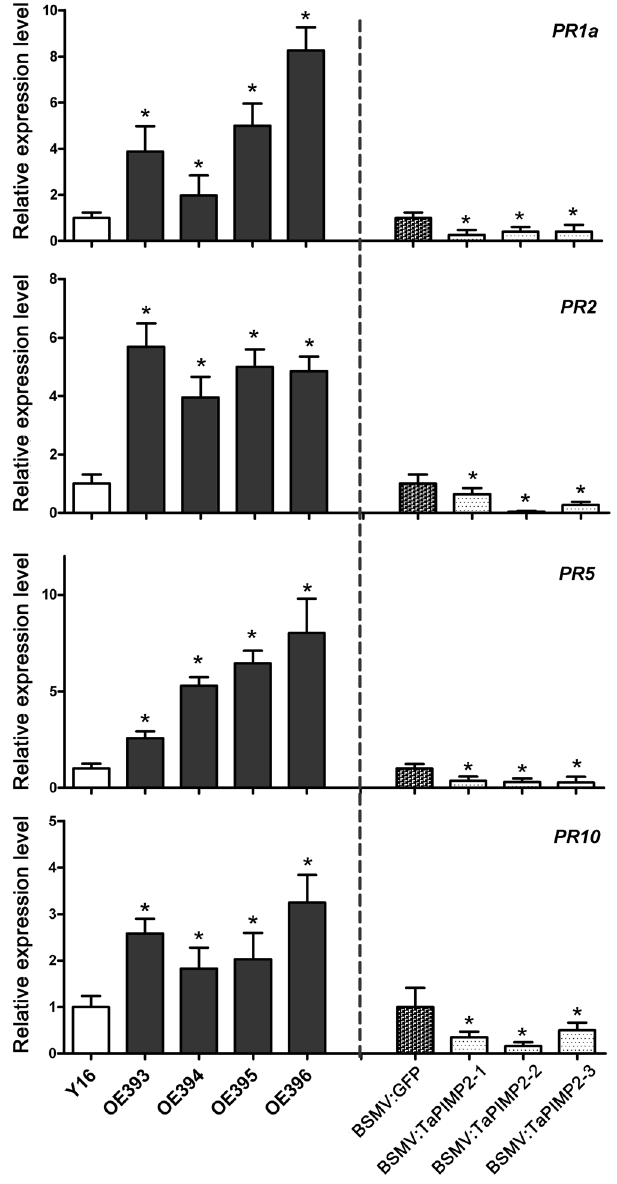
Figure 8. Expression of defense-associated genes in TaPIMP2-overexpressing wheat lines and TaPIMP2- silenced wheat plants by RT-qPCR. The transcript levels of these genes in TaPIMP2-overexpressing wheat lines are relative to those in untransformed Yangmai 16, whereas the levels in TaPIMP2-silenced wheat plants are relative to those in the control plants infected with BSMV:GFP. Values represent the average standard error of three independent biological replicates (Student’s t-test: * P <